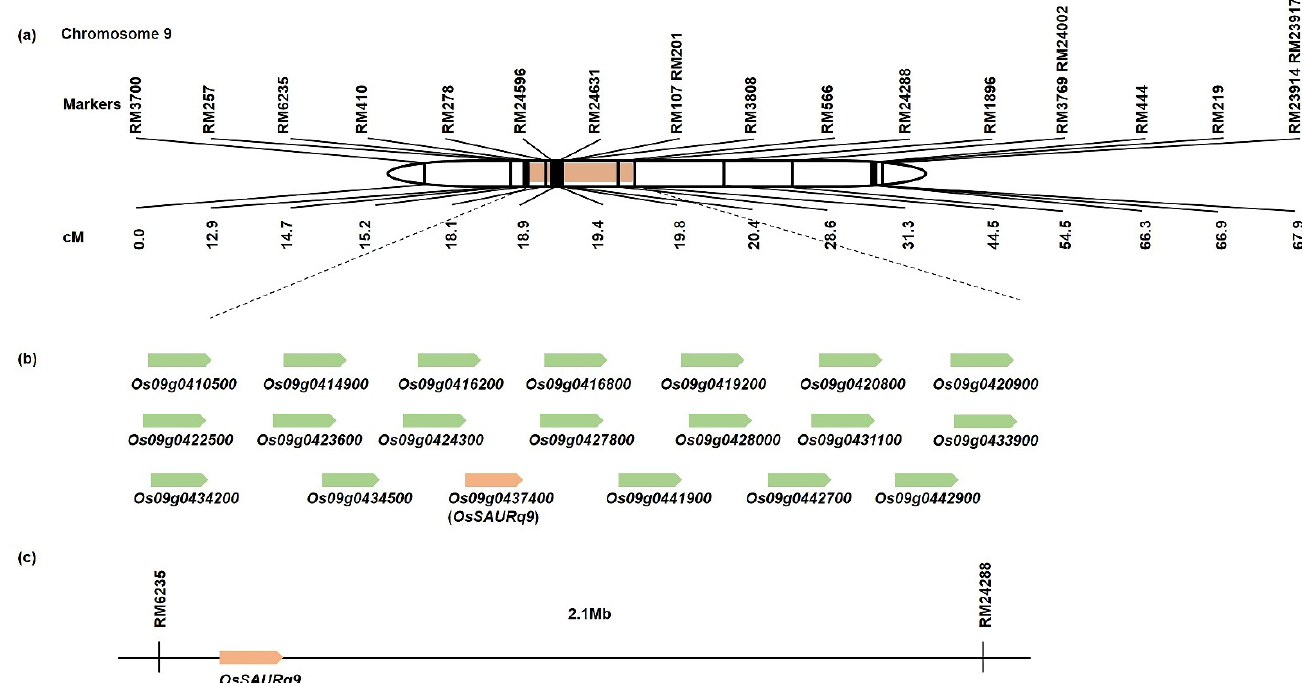
Figure 6. Physical mapping of the genes associated with tiller angle and tiller crown width. ( a ) Target marker interval RM6235–RM24288 on chromosome 9 that overlaps two years for tiller angle and tiller crown width. ( b ) Twenty representative related genes were predicted in the 2.1 Mb region between marker RM6235 and RM24288. ( c ) OsSAURq9 has finally been select as a target preferred gene related to rice tiller angle.